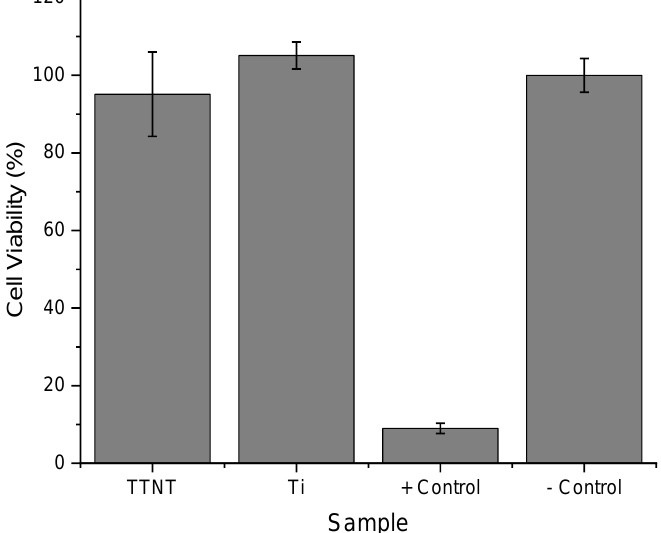
Figure 12. Cytotoxicity of Ti and TTNT discs extracts measured by MTT assay. + control (latex): indicates toxicity and—control (polystyrene): indicates the absence of toxicity. The results are expressed as mean ± standard deviation (SD) of six measurements for each group (n = 6).